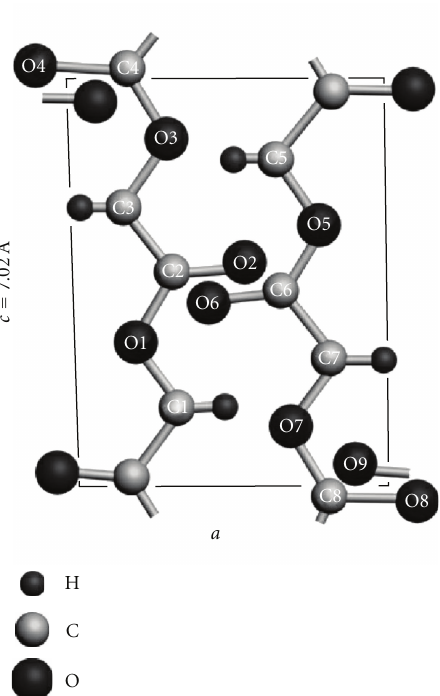
Figure 2: Crystal structure of poly(glycolic